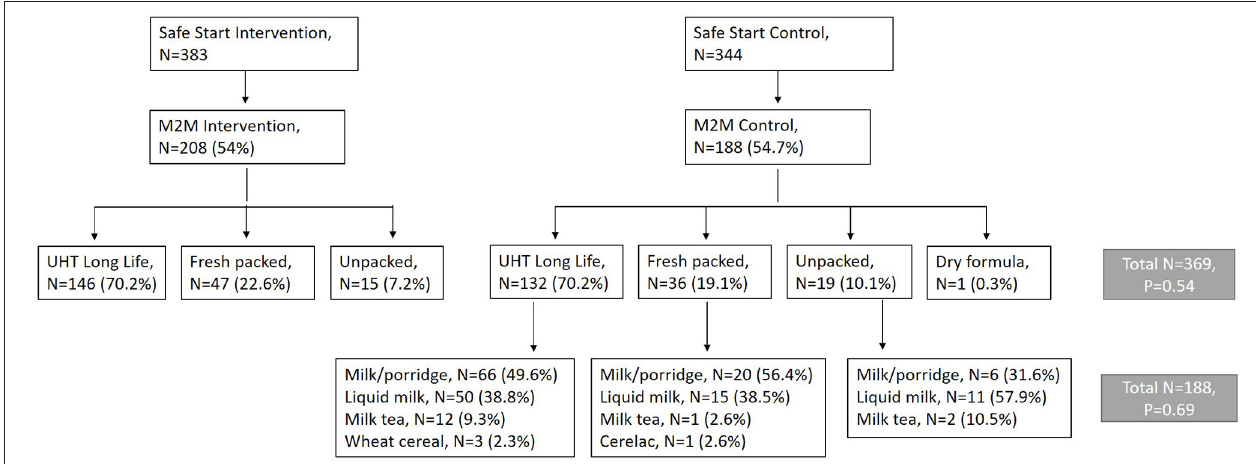
FIGURE 1 | Flow diagram showing recruitment of 396 Market to Mouth households from 726 caregivers enrolled in the Safe Start Study who completed a mid-intervention survey and purchased milk for feeding their infant and submitted a food sample for microbiological testing.